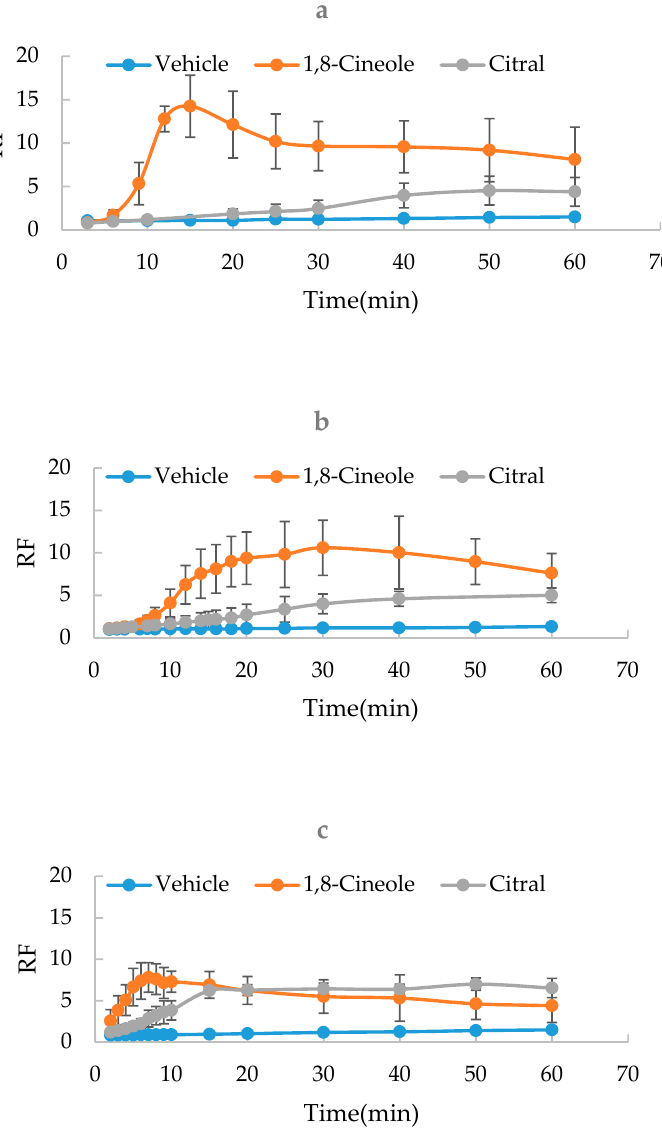
Figure 2. Effect of the phosphate buffered saline (PBS) concentration on SER kinetics of 1,8-cineole, citral and vehicle ( n = 3). ( a ) PBS1; ( b ) PBS2; ( c ) PBS3.